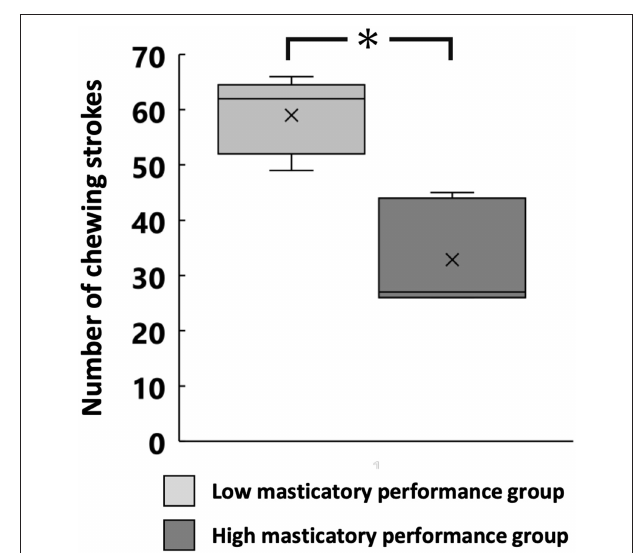
FIGURE 3 | Number of chewing strokes at swallowing threshold for each group. * p <